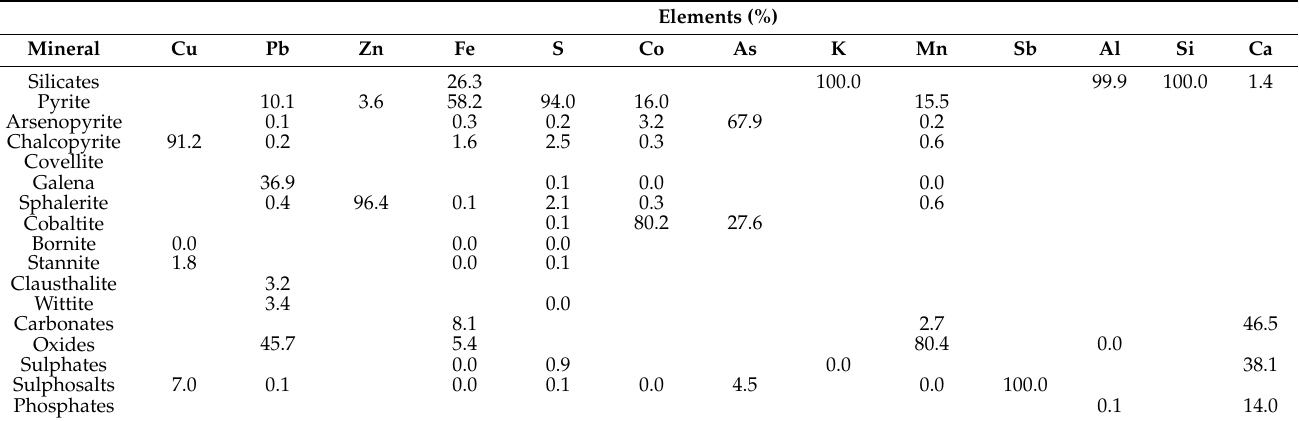
Table A10. The distribution of elements in the minerals (groups) present in the Neves Corvo waste rock (NC_01).